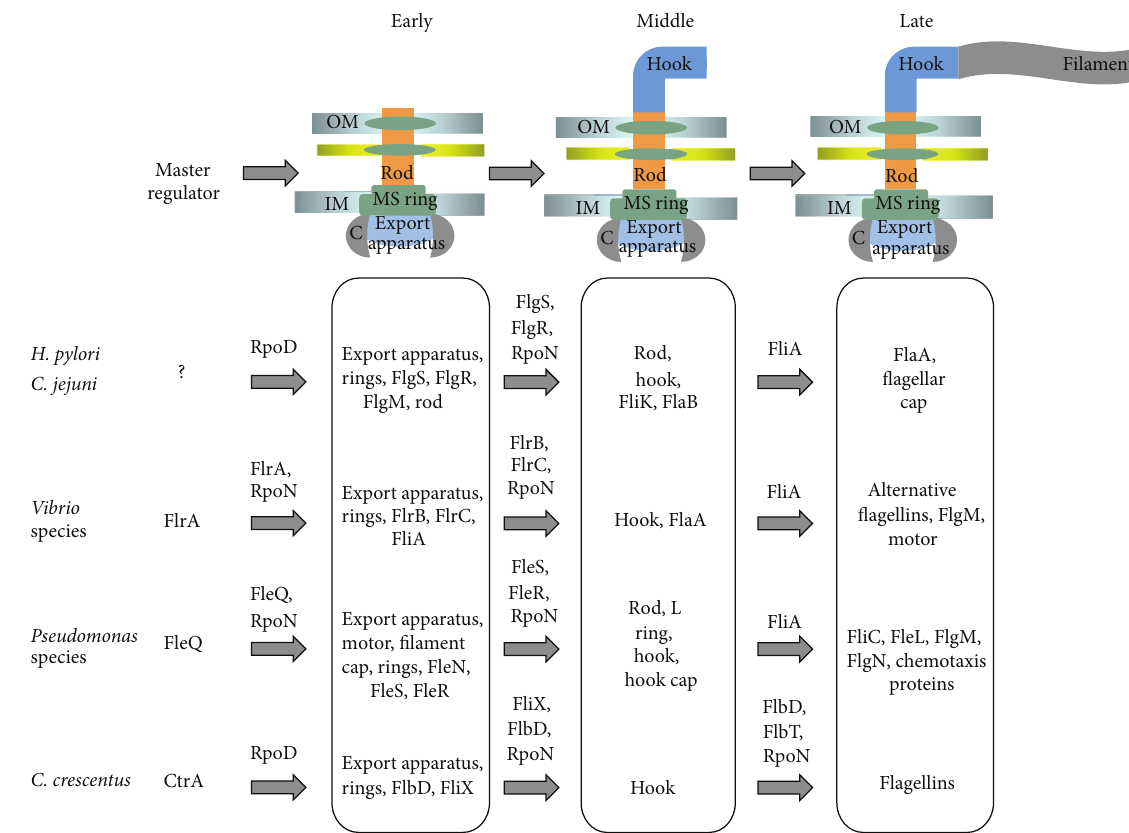
Figure 2: Diversity in flagellar gene transcription hierarchies. Transcriptional hierarchies are compared between the Epsilonproteobacteria, Vibrio , Pseudomonas, and C. crescentus . Regulatory proteins and sigma factors involved in controlling the transcriptional hierarchies are indicated above the arrows. Early, middle, and late genes are indicated between the